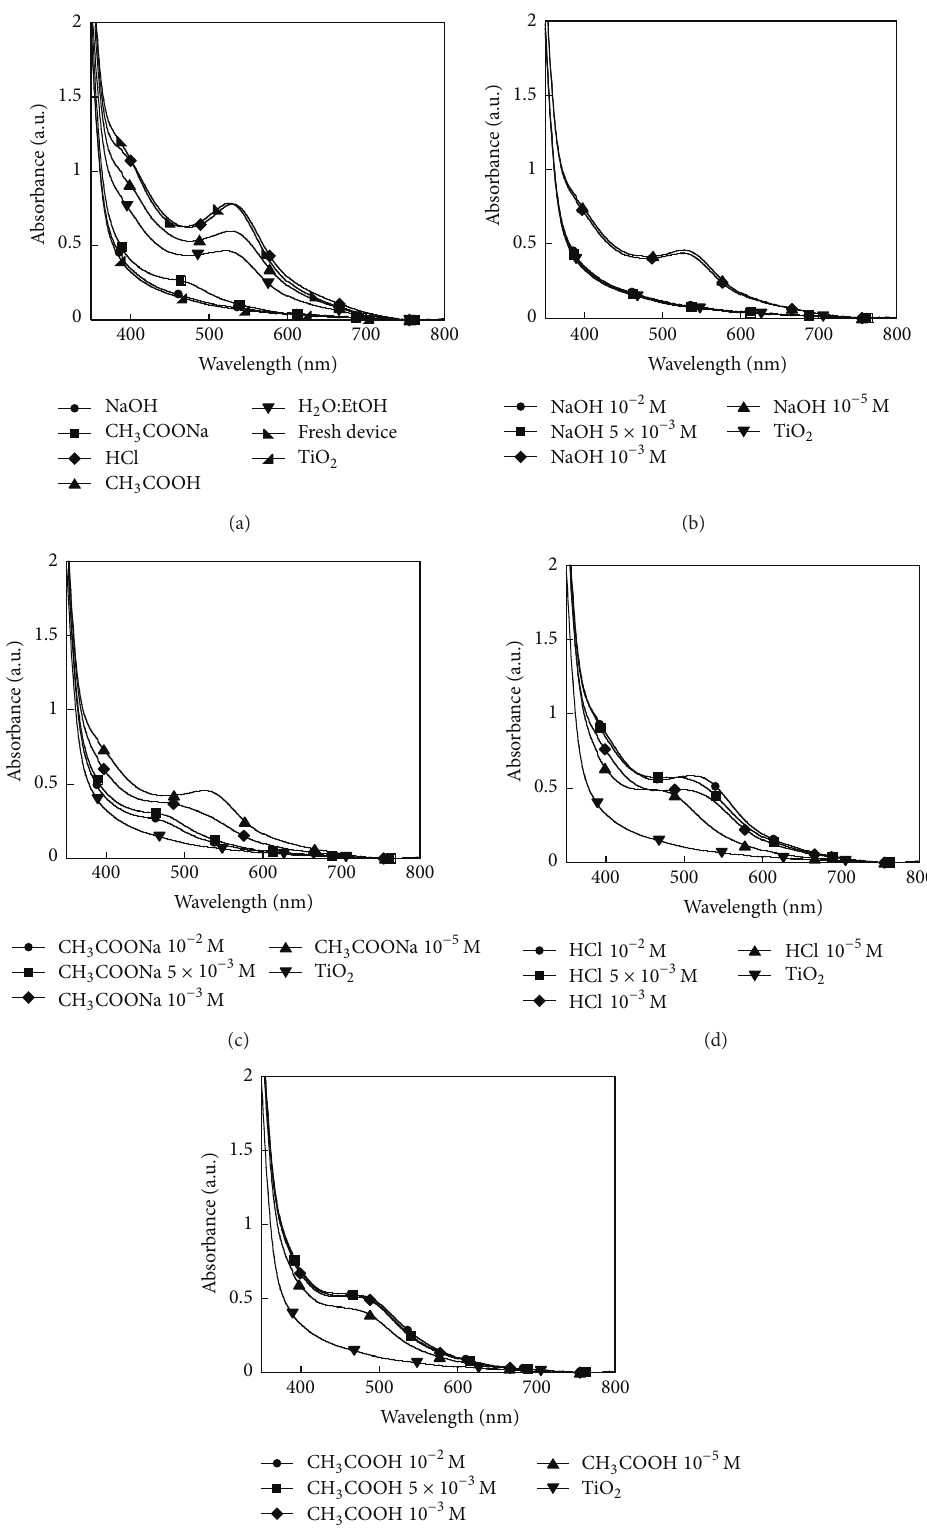
Figure 1: (a) UV-Vis absorption spectra of TiO 2 substrates after desorption using NaOH, CH 3 COONa, HCl, CH 3 COOH, and DI water with ethanol solutions. UV-Vis absorption spectra of dyed TiO 2 films after immersion in (b) NaOH and (c) CH 3 COONa for two minutes and (d) HCl and (e) CH 3 COOH solutions for sixteen hours at various